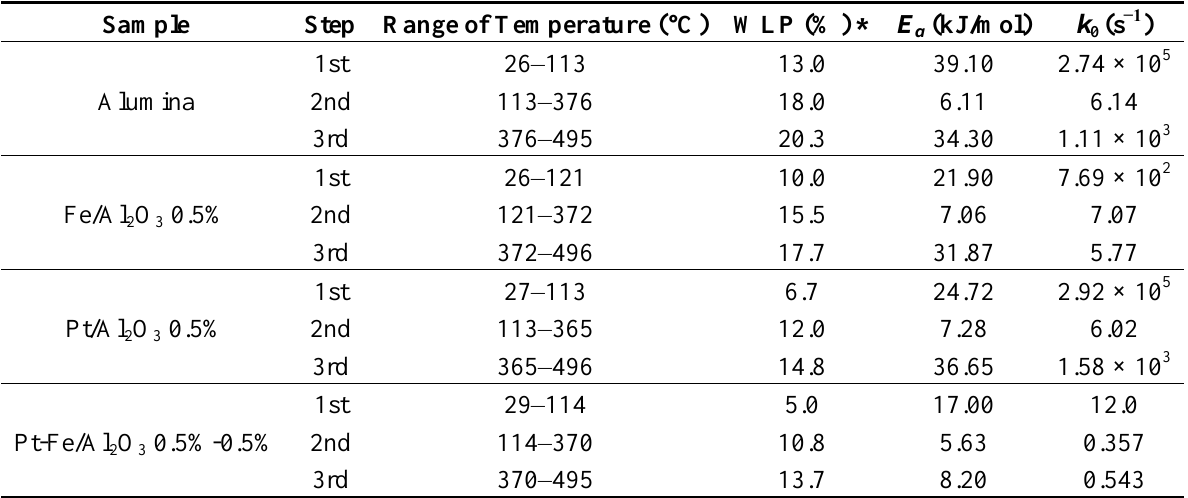
Table 2. Thermogravimetric data at collected at 10 °C/min under N activation energy according to Equation